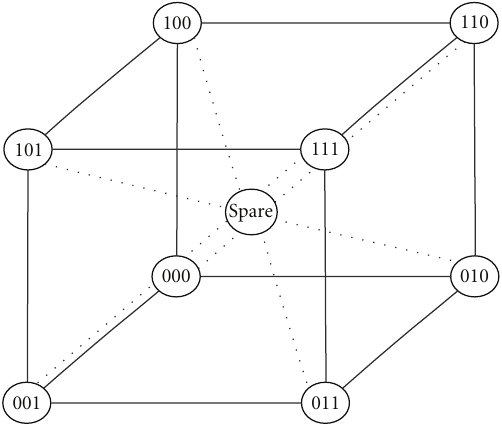
Figure 2: The standby spare technique.